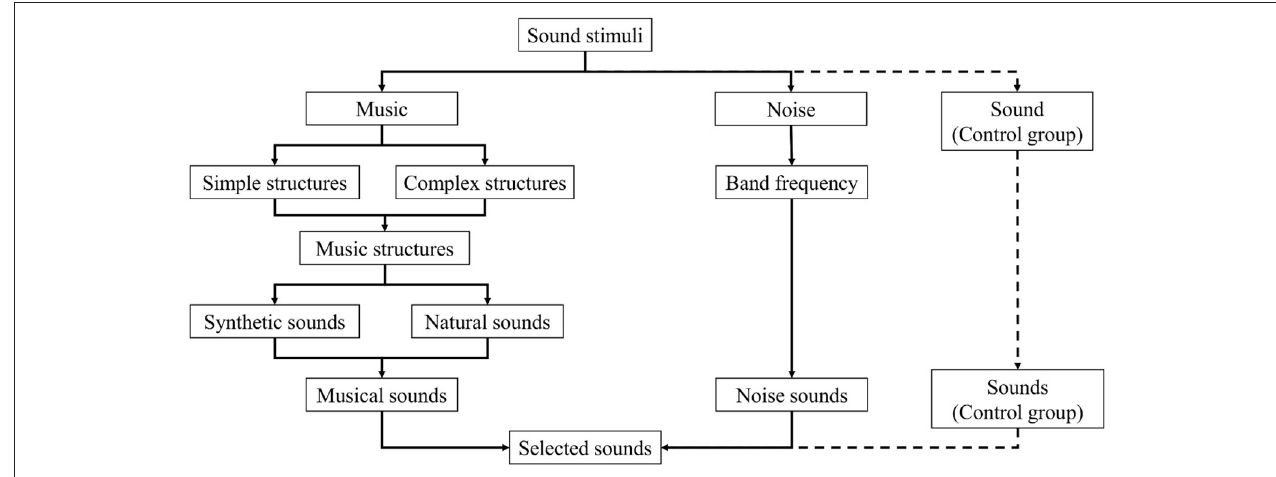
FIGURE 3 | A general flow diagram to select the sound stimuli.